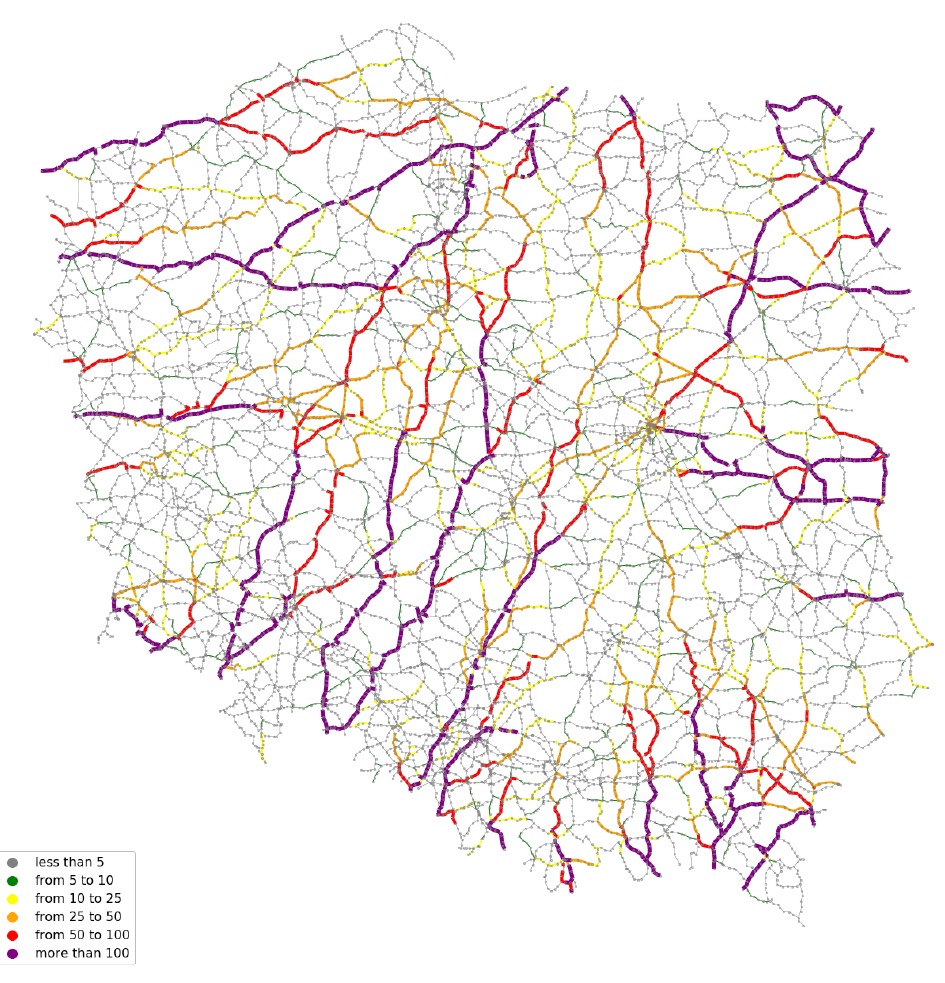
Figure 5. Traffic volume assessment results for foreign trips.